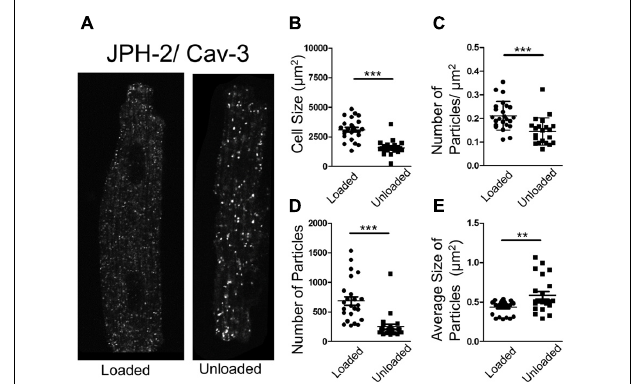
FIGURE 3 | (A) Illustrative traces of LTCC activity recorded in ‘cell-attached’ mode from loaded and unloaded cells. (B) Graph comparing the occurrence functional LTCC’s within different cellular microdomains of loaded or unloaded cells. A sub-population of loaded and unloaded cells were treated with the non-specific LTCC agonist BAYK8644. (C) Graph comparing the open probability of LTCC’s within different cellular microdomains of loaded or unloaded cells (loaded t-tubule 0.073 ± 0.011% vs. loaded crest 0.027 ± 0.006% N,n 5/18-26 mean ± SEM ∗ p < 0.05) (unloaded t-tubule 0.0350 ± 0.003% vs. unloaded crest 0.025 N,n 5/20-30 mean ± SEM NS). # p < 0.05 vs. loaded t-tubule. (D) Graph comparing the mean capacitance of loaded and unloaded cardiomyocytes (loaded 142.1 ± 8.65 pF vs. unloaded 91.67 ± 5.40 pF N,n 5/11-15 mean ± SEM ∗∗∗ p < 0.001). (E) Graph comparing the mean I Ca of loaded and unloaded cardiomyocytes (loaded -5.67 ± 0.64 pA/pF vs. unloaded –4.62 ± 0.46 pA/pF N,n 5/11-14 mean ± SEM NS).